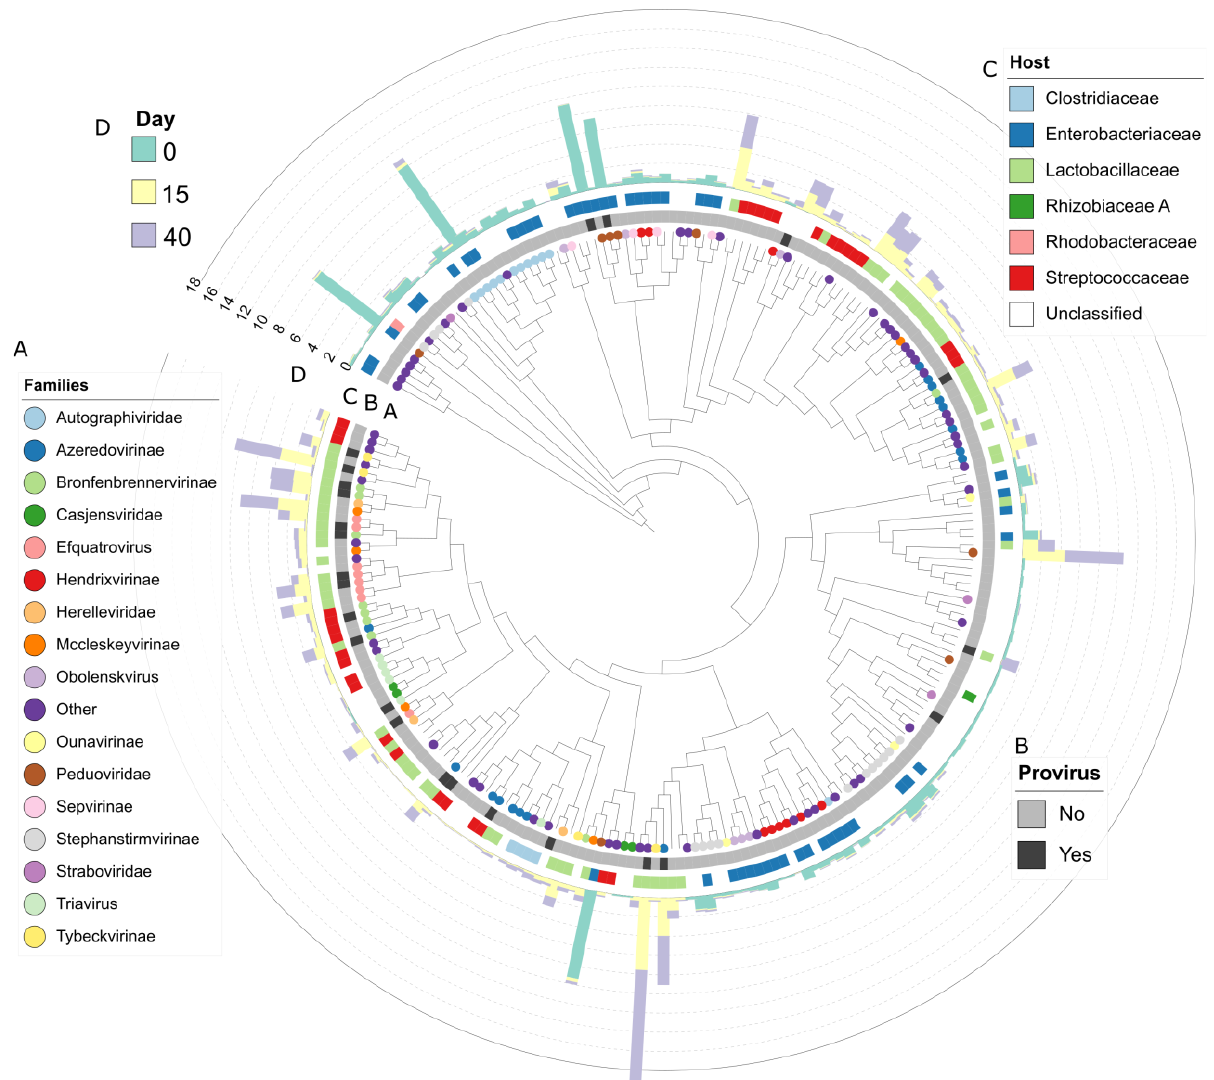
Figure 6. Phylogenetic relationship of 240 vOTUs recovered during 40 days of grass ensilaging and their abundance across time. The plot displays the changes of the relative abundance of the different vOTU across time, their taxonomic classification and potential host. The tree was constructed using the predicted proteins of each vOTU and the Virus Classification and Tree Building Online Resource (VICTOR). Each branch represents a unique vOTU (240 total). The colored circles indicate the viral family ( A ), grey/black squares ( B ) if they are provirus, colored squares are the predicted host ( C ), and the bar plot ( D ) shows the relative abundance of each vOTU at 0 (green), 15 (yellow), and 40 (purple) days.